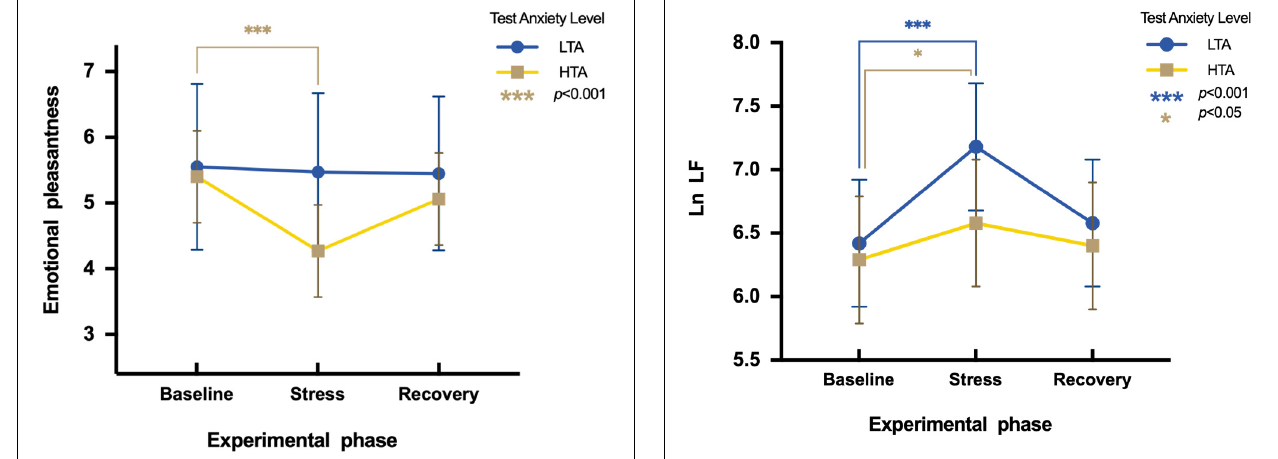
FIGURE 3 | Differences in emotional pleasantness during three experimental phases of HTA and LTA individuals. ∗∗∗ represents a significant difference between the baseline and stress phase of HTA individuals with p -value < 0.001.